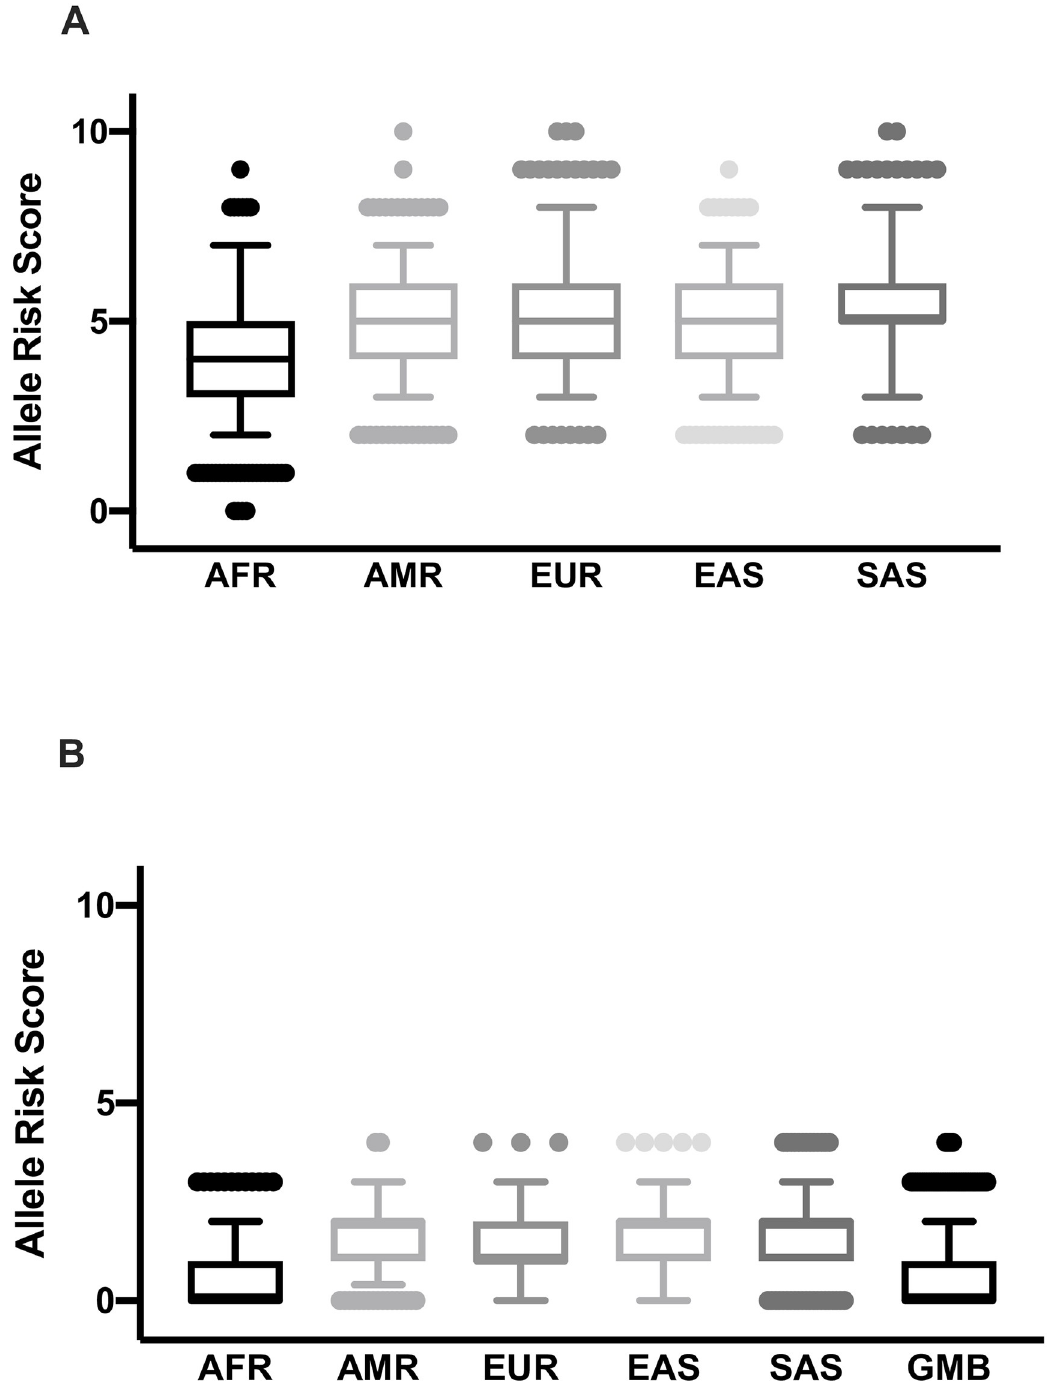
Fig 8. Distribution of the number of high iron risk alleles across global populations. (A) Distribution of the number of high iron risk alleles across five populations. (B) Distribution of the number of high iron risk alleles in three SNPs in the MRC Keneba Biobank (Gambian) and other populations. Designation of the allele (risk or not) was determined by their previously published information as presented in S1 and S2 Tables. AFR, African; EUR, European; AMR, American; EAS, East Asian; SAS, South Asian.